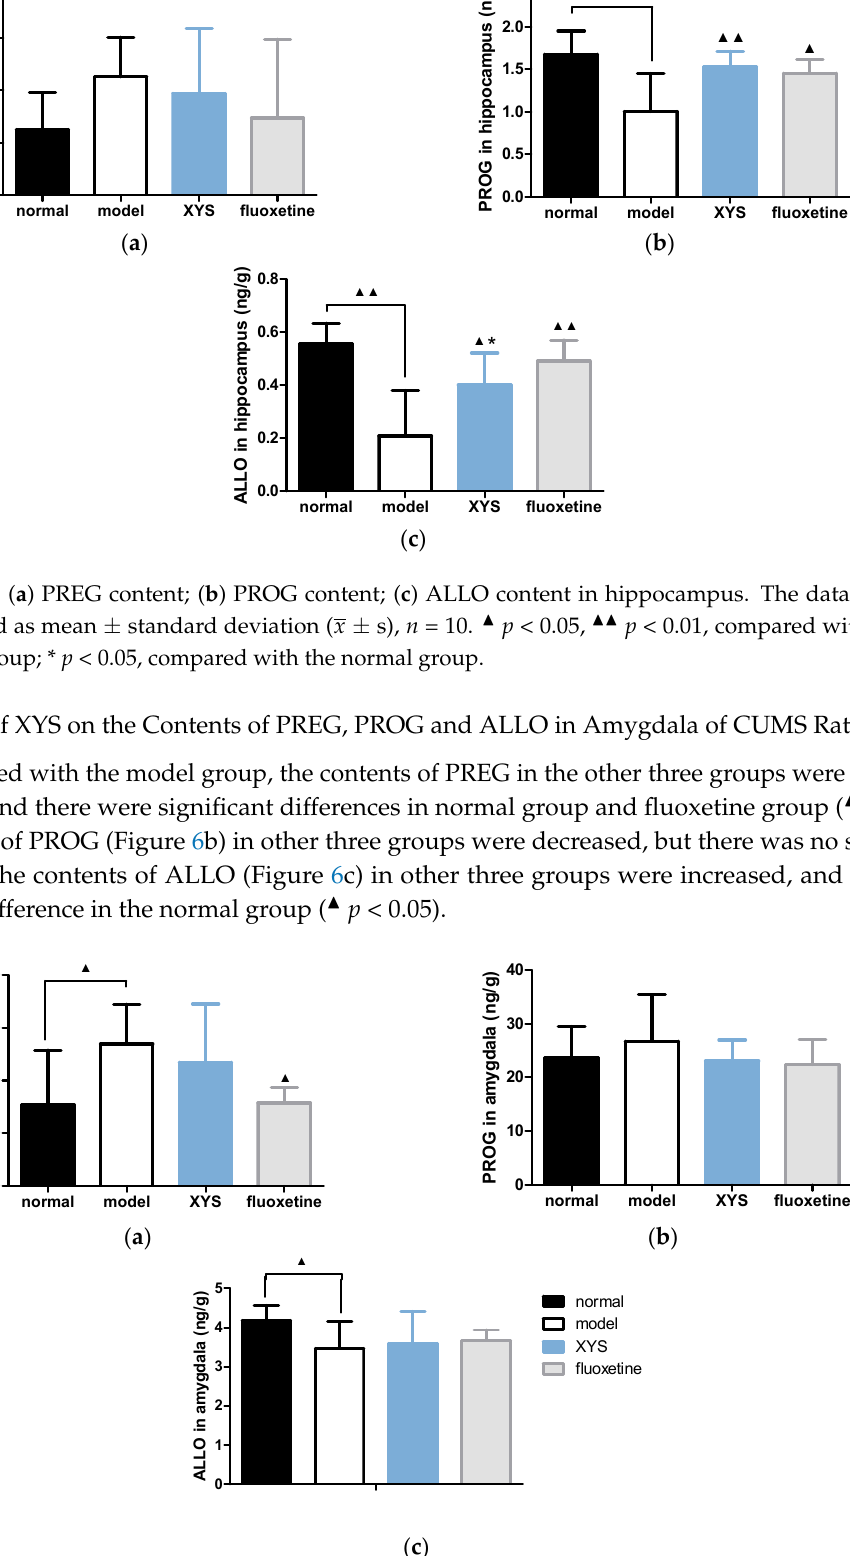
Figure 6. ( a ) PREG content; ( b ) PROG content; ( c ) ALLO content in the amygdala. The data were expressed as mean ± standard deviation ( (cid:1876)̅ ± s), n = 10. ▲ p < 0.05, compared with the model group.